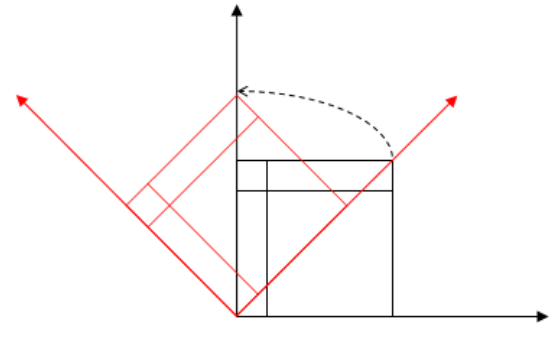
Figure 1. Graphic representation of 2D Helmert transformation General formula is